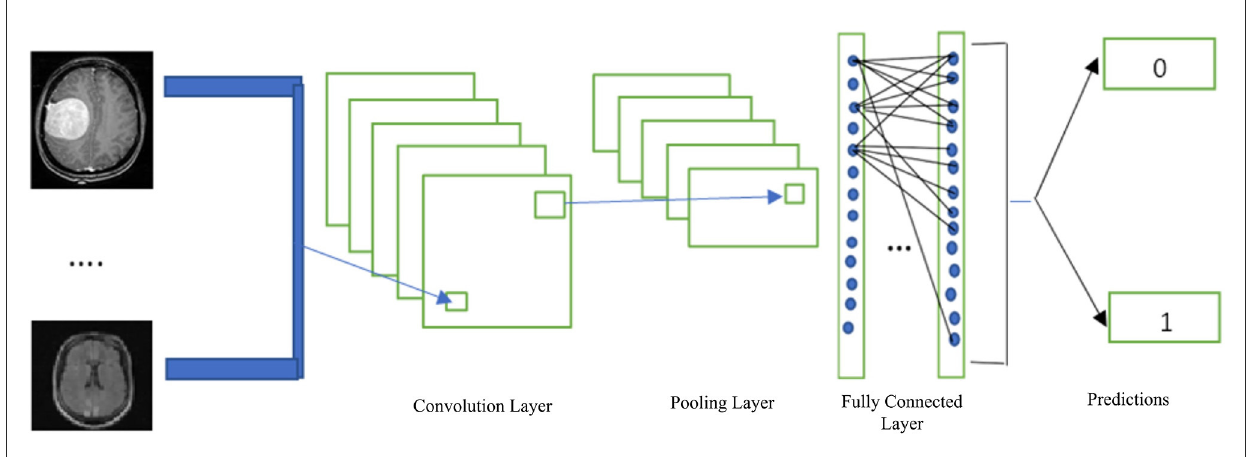
FIGURE5 Basic CNN architecture (Hinton, 2012).